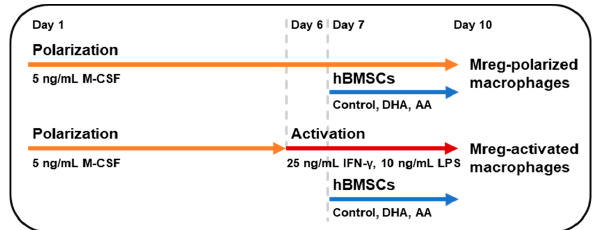
Figure 1. The layout of macrophage polarization assay. Mreg, regulatory macrophage;